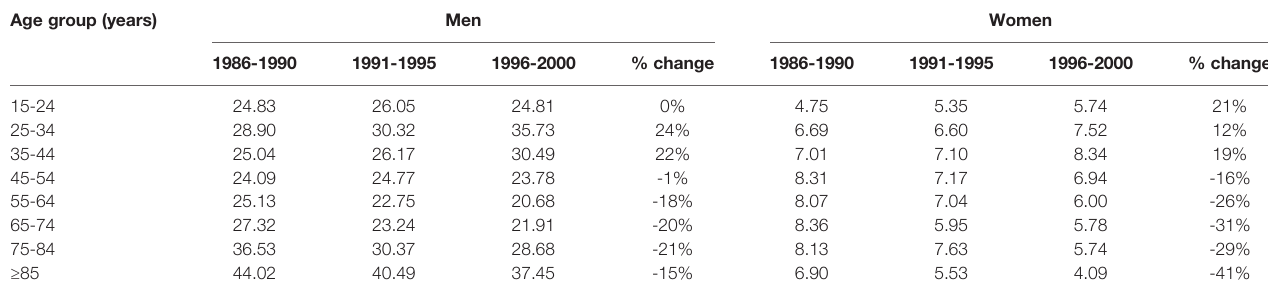
TABLE 1 | Suicide rates (per 100,000) in Australia by sex and age, 1986-2000. Age group